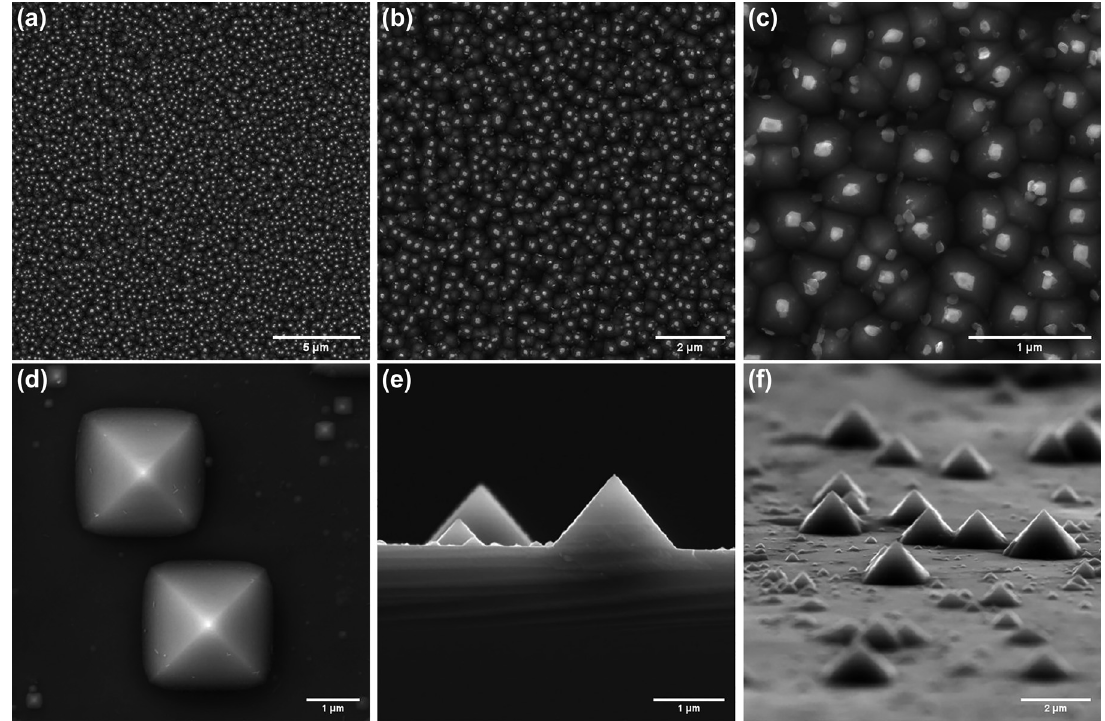
Figure 3: Formation of self-aligned catalyst nanoparticles on apexes, and completely fabricated nanotips. (a–c) Different magnifications of a typical being-formed array using nanoparticles masks and anisotropic etching in a 20% KOH solution at 65 ◦ C. The thickness of the deposited Ni layer is about 15 nm. Top surface (d), cross-sectional (e), and tilted (f) SEM images of generated nanotips without catalyst particles. The etching time is about 6